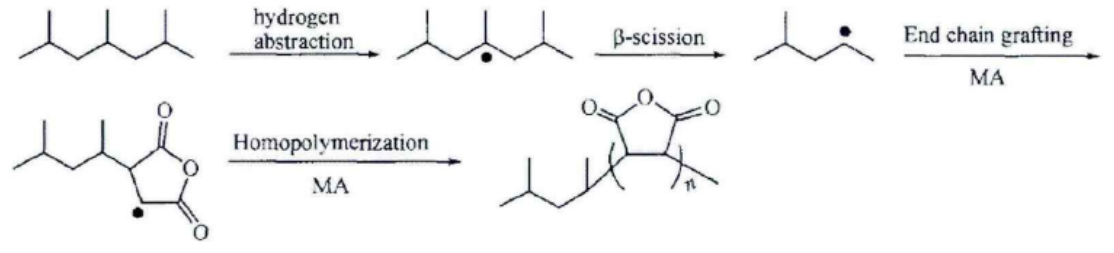
Figure 1. The formation of polypropylene macromolecule free radical.